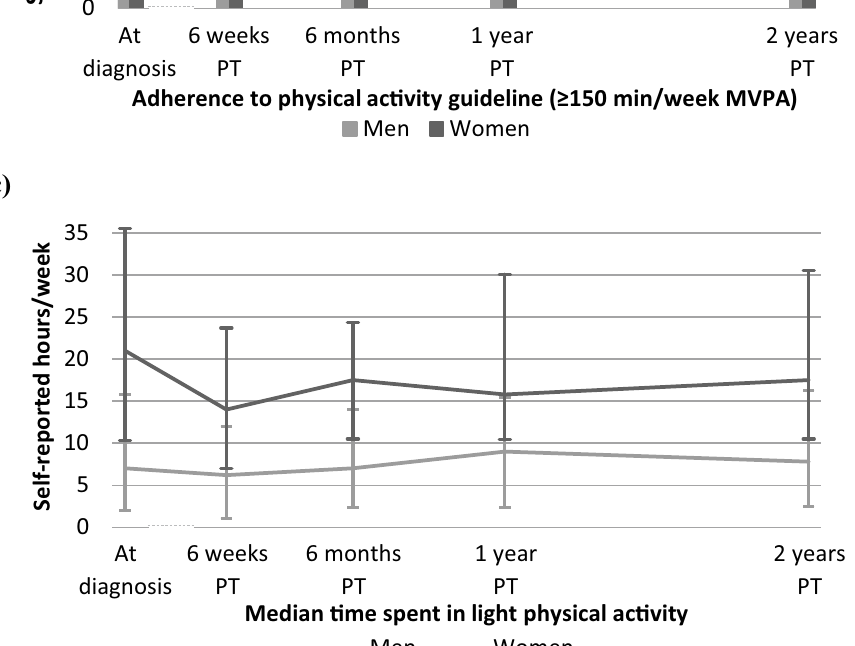
Figure 2. Sex-stratified medians and interquartile ranges of self-reported ( a ) hours/week of moderate-to- vigorous physical activity (MVPA), ( b ) percentage self-reported adherence to physical activity guideline (≥ 150 min/week of MVPA), and ( c ) hours/week of light-intensity physical activity (LPA) at diagnosis and at post-treatment (PT) time points among colorectal cancer survivors included in the current analysis (n =